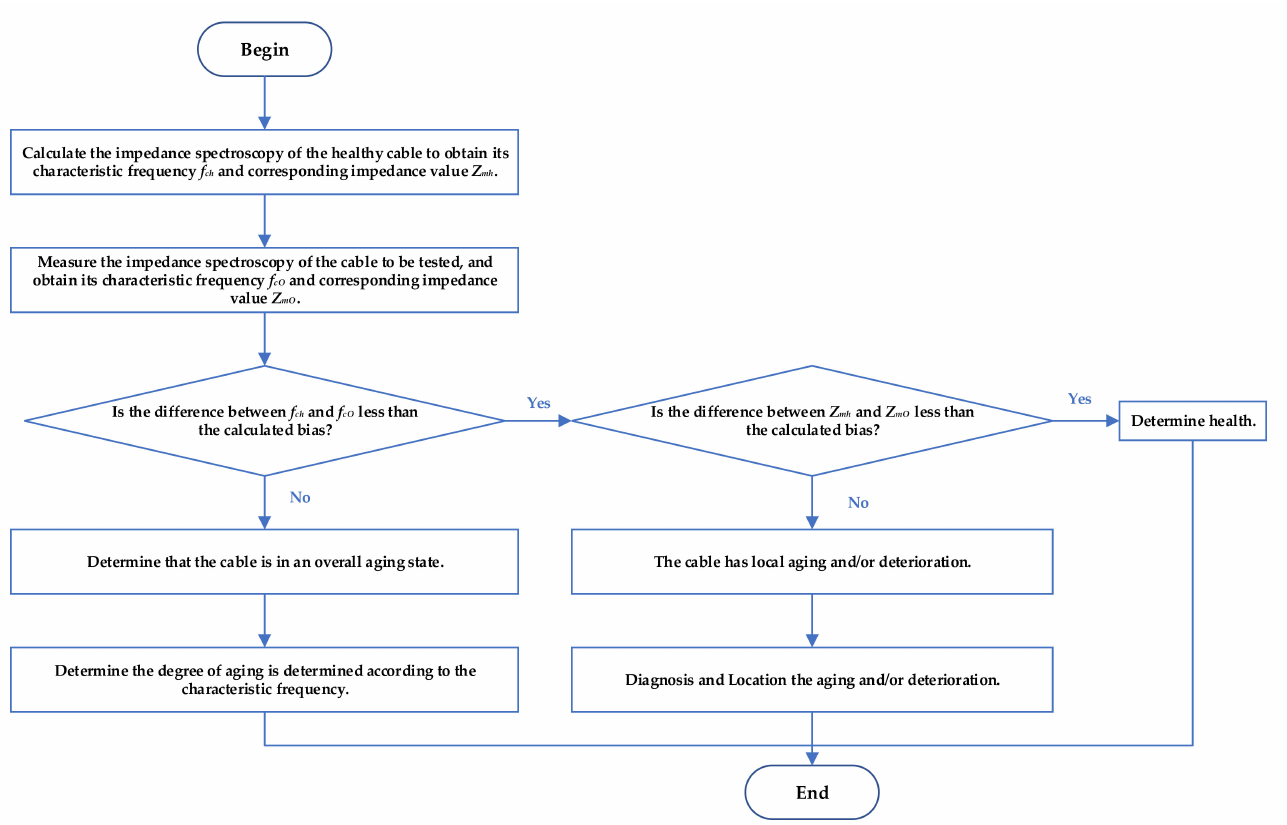
Figure 10. The schematic diagram of the procedure for diagnosis and location of cable